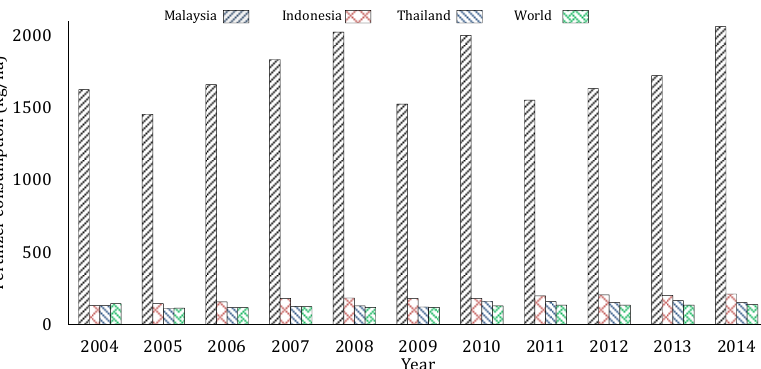
Figure 1. Fertilizer consumption per ha of arable land (Source of data: FAO, 2016)